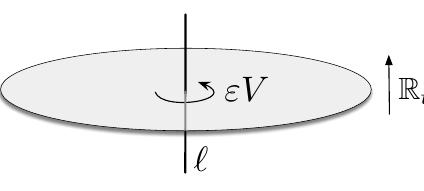
Figure 4 . Introducing an Omega background for rotations about ‘